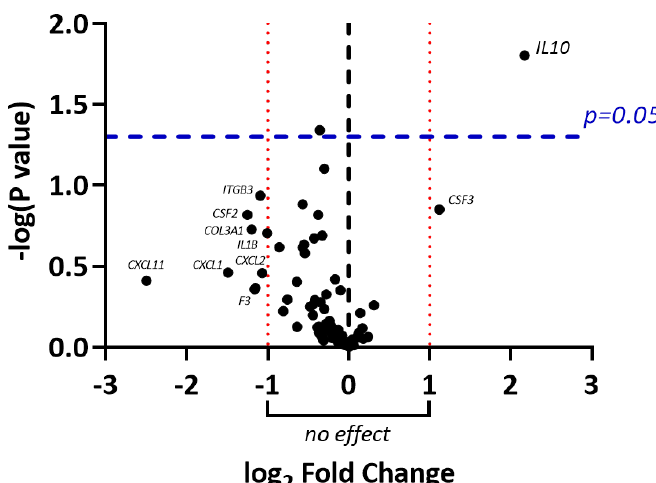
Figure 4. Volcano plot showing the entity of gene up/downregulation induced by RNLE treatment (100 µg/mL) in HaCaT cells stimulated with TNF-α (10 ng/mL, 6 h) together with statistical signifi- cance. Only genes with absolute fold change greater than 2 (log 2 fold change greater than 1) and p < 0.05 were considered significantly regulated.